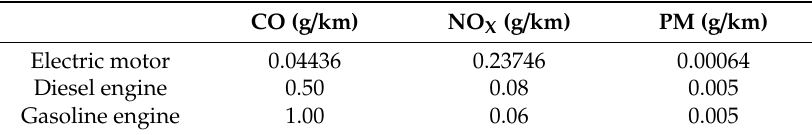
Table 8. Comparison of electric vehicle emissions with the EURO 6